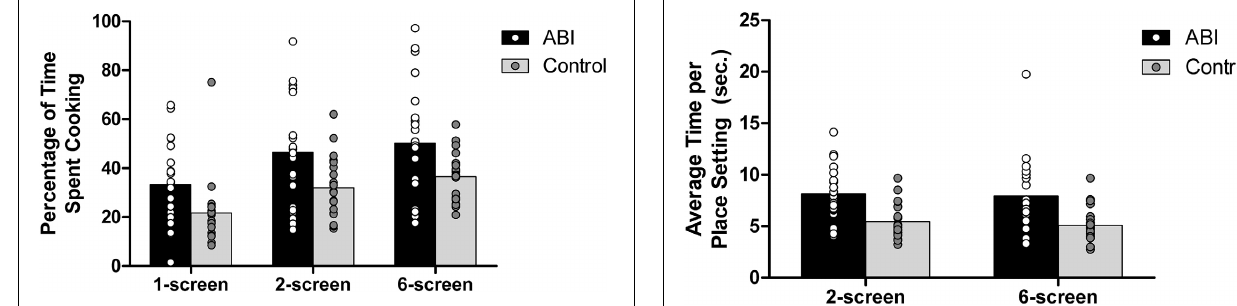
FIGURE 8 | Percentage of time spent cooking.